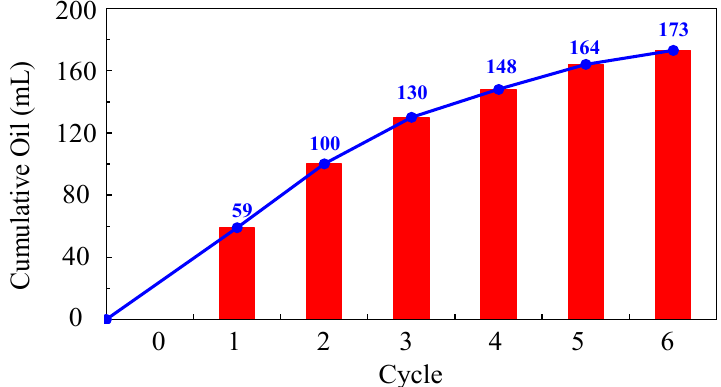
Figure 8. Cumulative oil production of each cycle of case one.